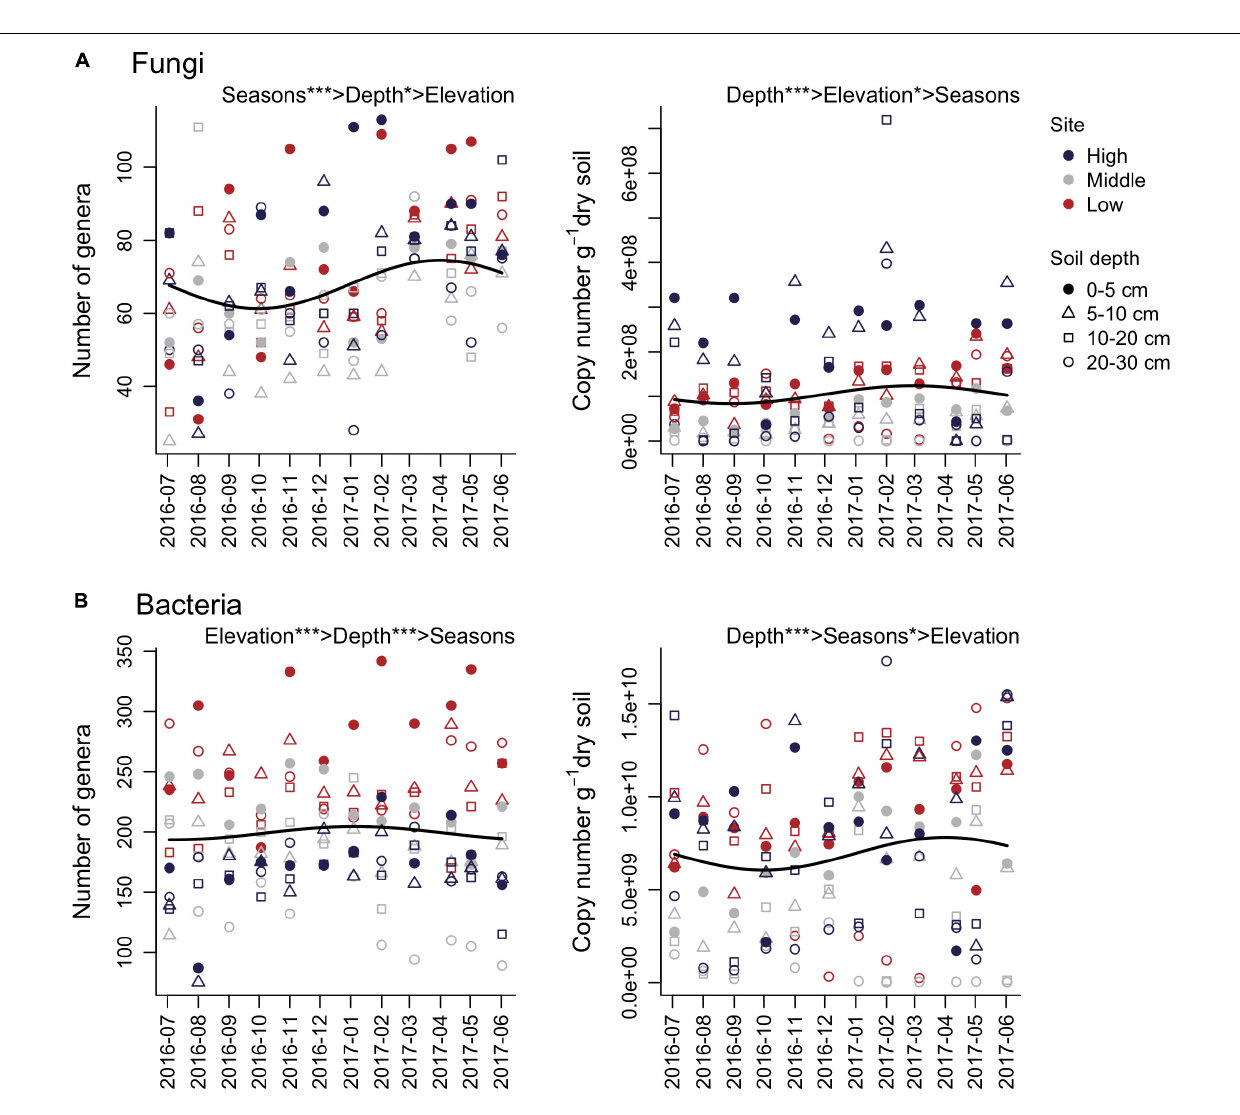
FIGURE 1 | Seasonal dynamics of the number of genera and gene copies of soil fungi (A) and bacteria (B) . The time series starts on July 3, 2016. The importance of seasons (cosine and sine function with 1-year periodicity; Sc and Ss ), elevation, and soil depth are denoted (e.g., Elevation > Depth shows that elevation has higher relative importance than soil depth). Solid lines represent fitted equations from multiple regression analyses based on Sc and Ss . ∗∗∗ P < 0.001 and ∗ P < 0.05.